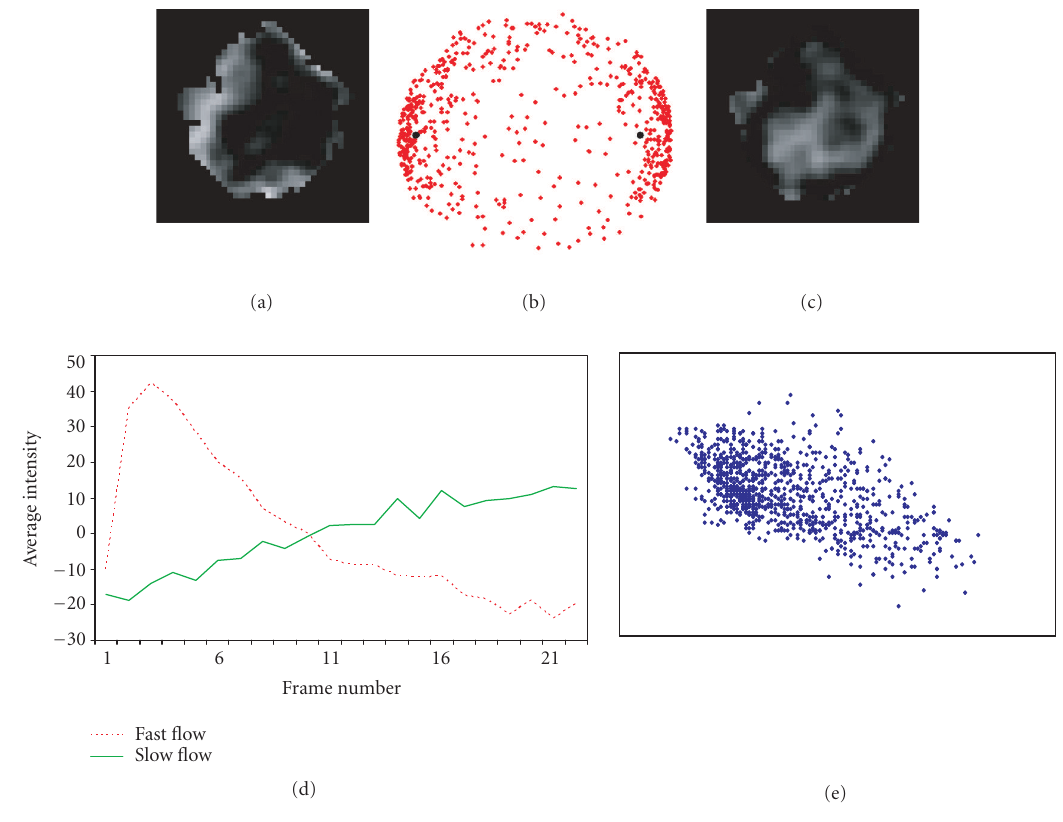
Figure 5: (b) shows the projected distribution of pixel TAC vectors (the dot plot represented in (b) is the two-dimensional projection of the component TAC clusters) whose two centers correspond to the fast and slow source TACs, respectively (the associated/extracted source images are given in (a) and (c)). (d) shows the kinetics of source TACs displayed as the time-course patterns and (e) shows the scatter plot of the source images showing the correlation